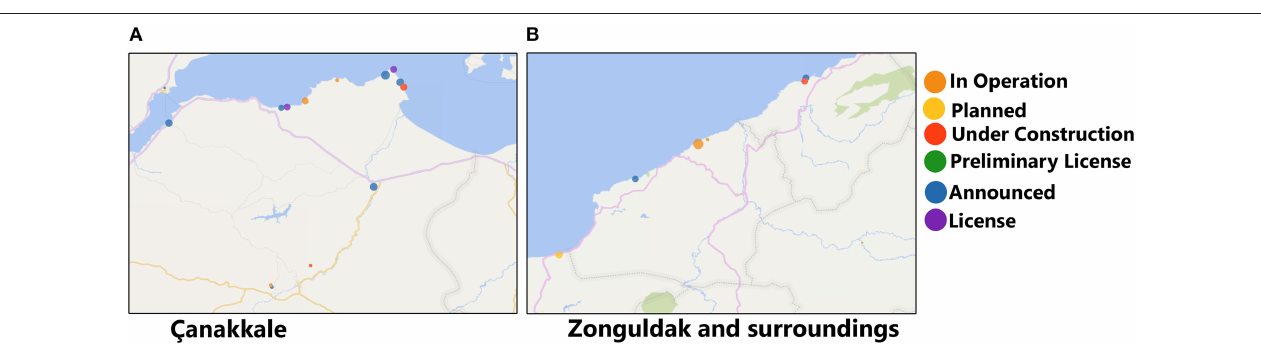
FIGURE 15 | The coal power plants in (A) Çanakkale and (B) Zonguldak and surroundings ( Source: own elaboration, using data provided by TEMA Foundation